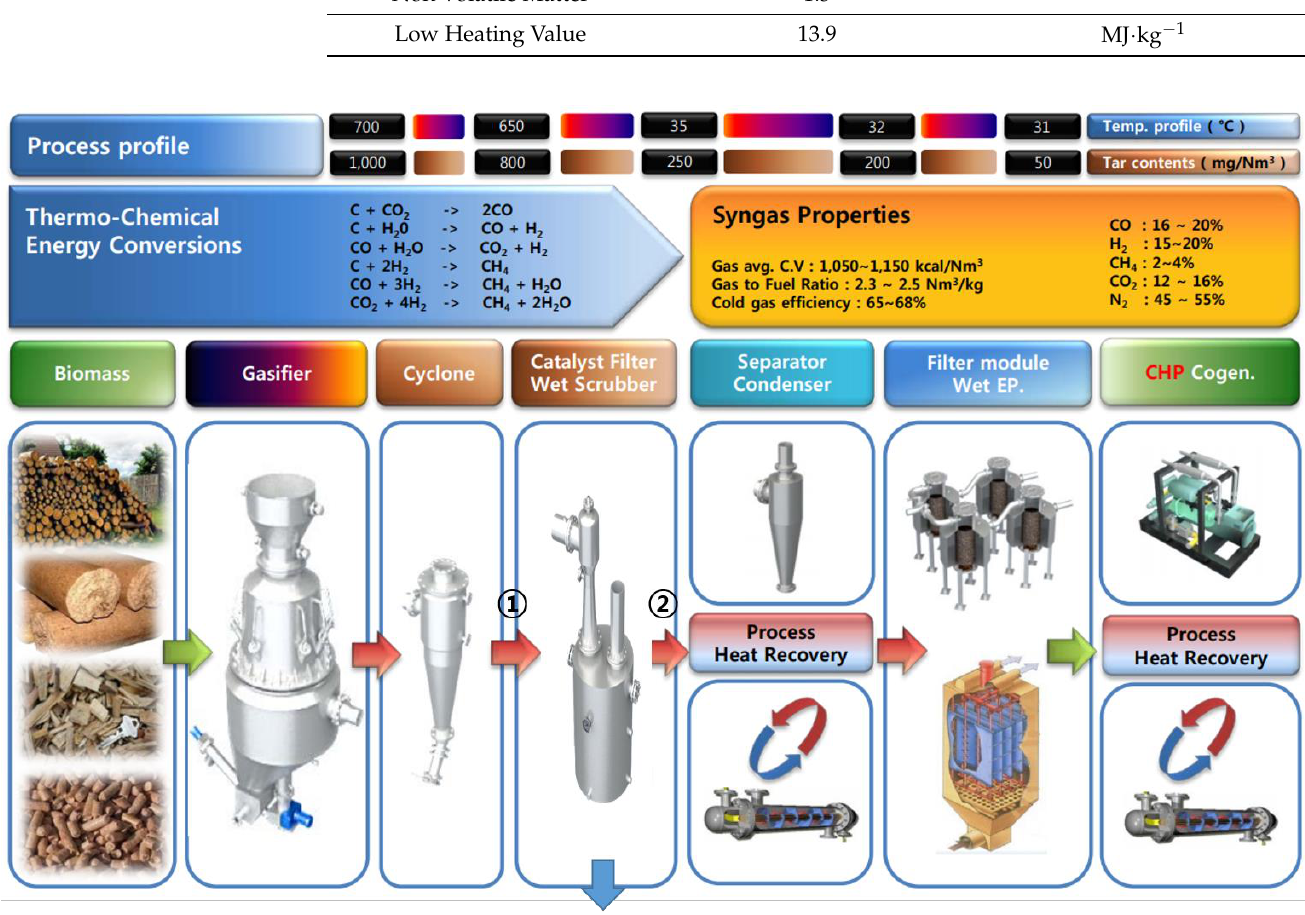
Figure 7. Process diagram demonstrating power generation facilities and characteristics of tar and syngas generation in operation: ① , ② Syngas sampling point (Original source of diagram: Samyang Econergy Inc. in Korea).